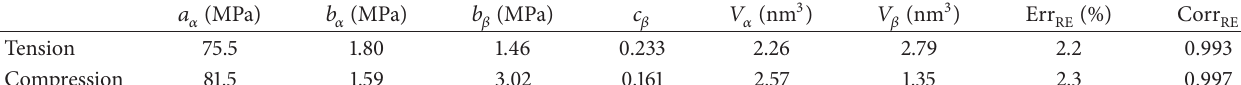
Table 2: Material constants, activation volumes, error, and correlation of the Ree-Eyring equation.